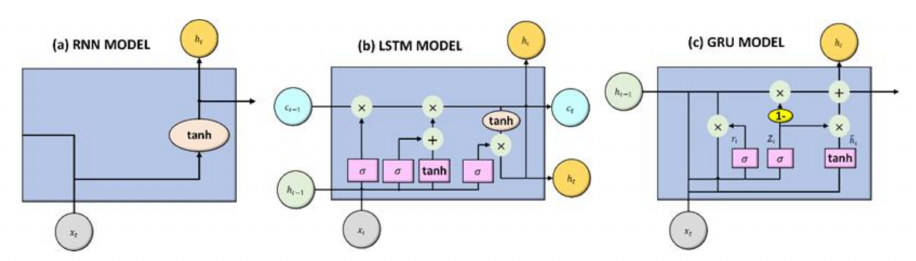
Figure 1. The topological structure of RNN, LSTM, and GRU for short-term prediction: ( a ) the recurrent neural network (RNN), ( b ) the Long short-term memory (LSTM), and ( c ) the recurrent unit neural network